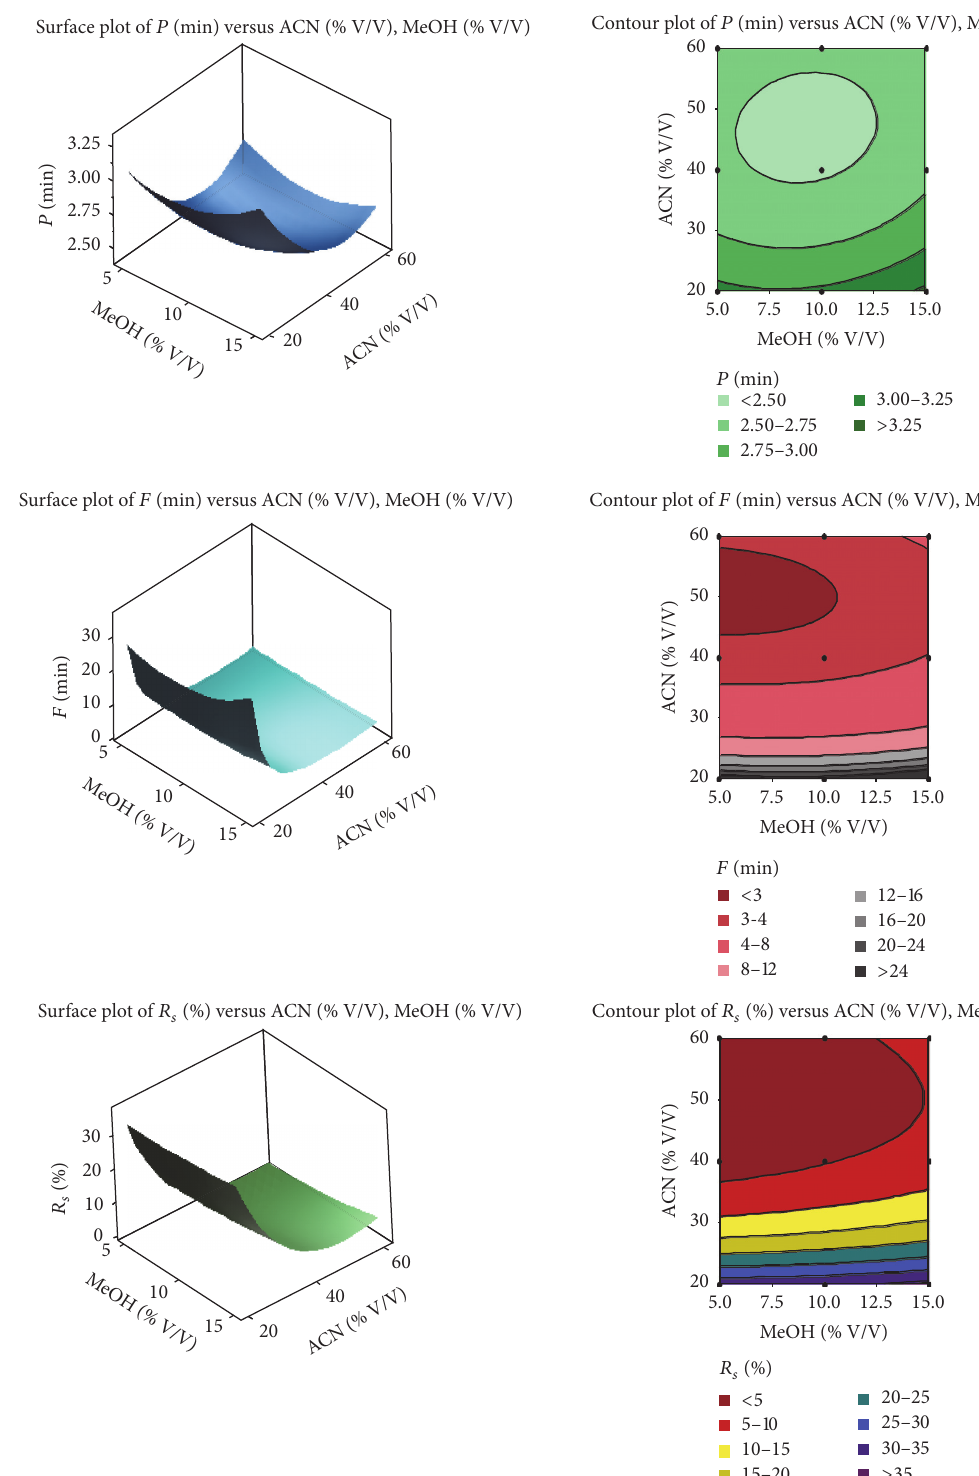
Figure 2: Three-dimensional response surface graphs and individual contour